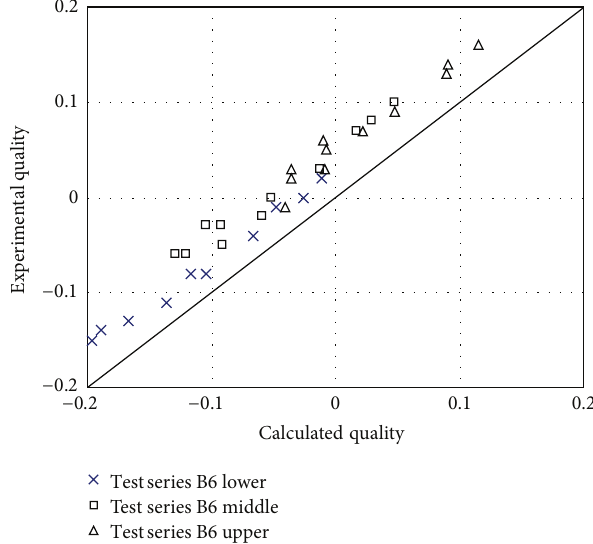
Figure 16: Deviation of measured quality from recalculated quality for test series 1 and 2.